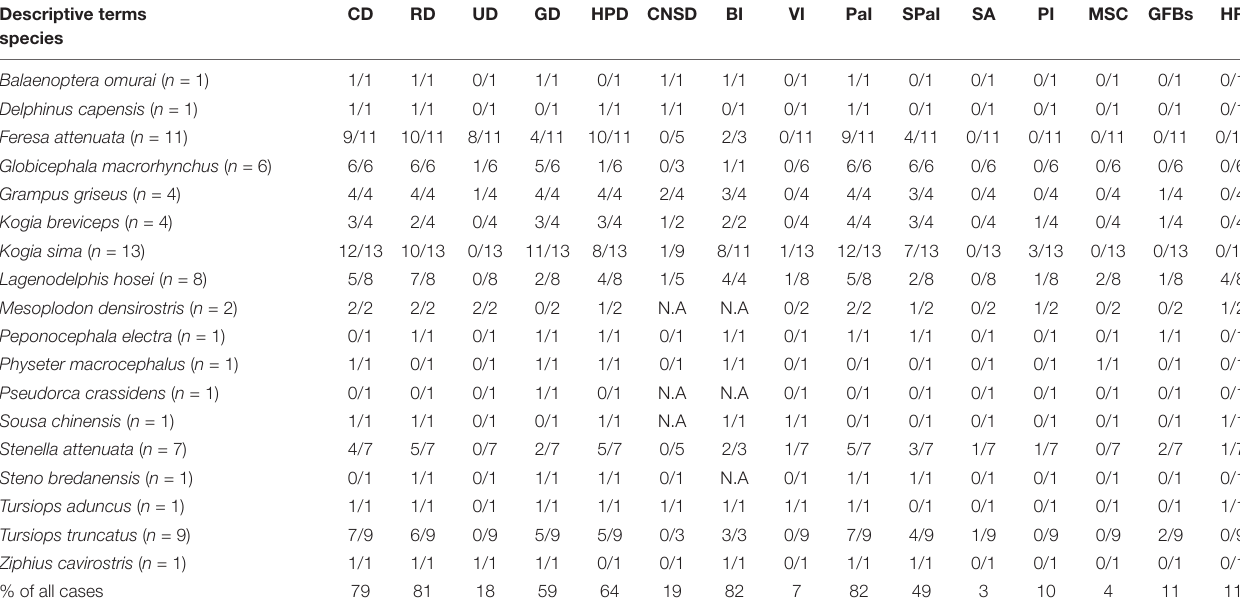
TABLE 1 | Stranded cetaceans of the present study in Taiwan from 2001 to 2013.